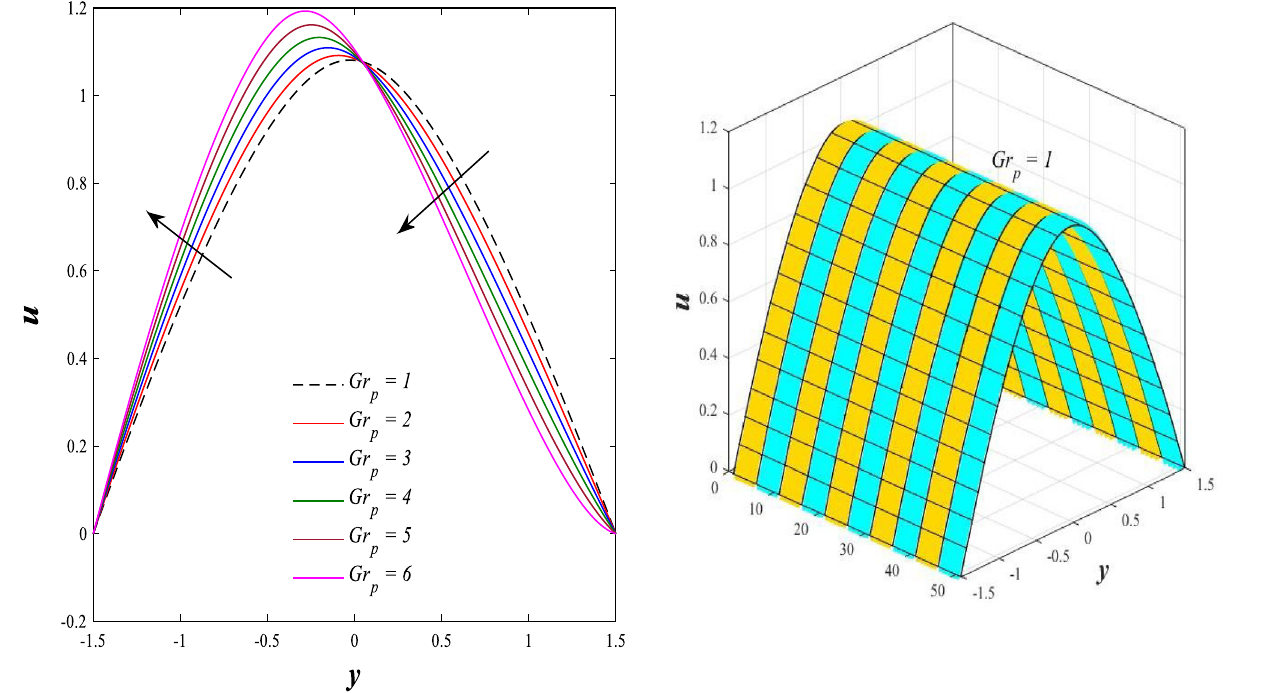
Figure 7. Effect of nanoparticles Grashof number Gr p on the axial velocity distribution 2D and 3D.